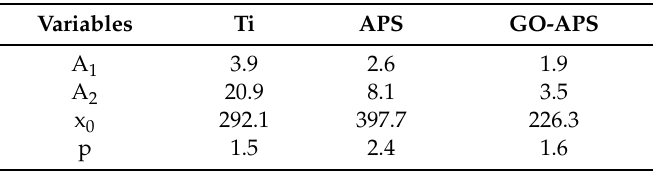
Figure 13. Variation of the friction force of Ti substrate and prepared coatings with the change of sliding speed (applied load: 100 nN; scan area: 2 µ m × 2 µ m). Table 2. Variables of Equation (4) for Figure